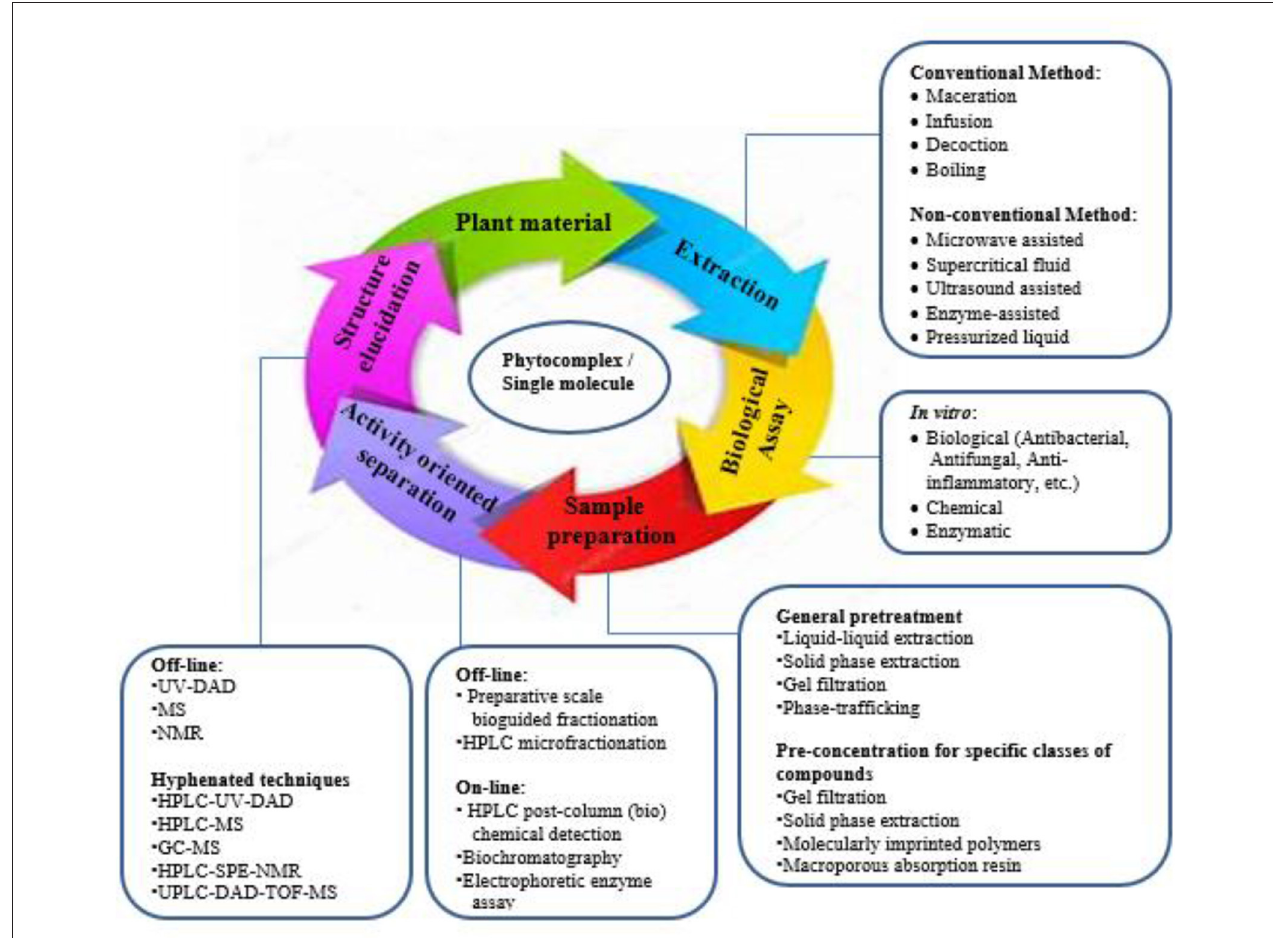
FIGURE 3 | Ethno-pharmacological